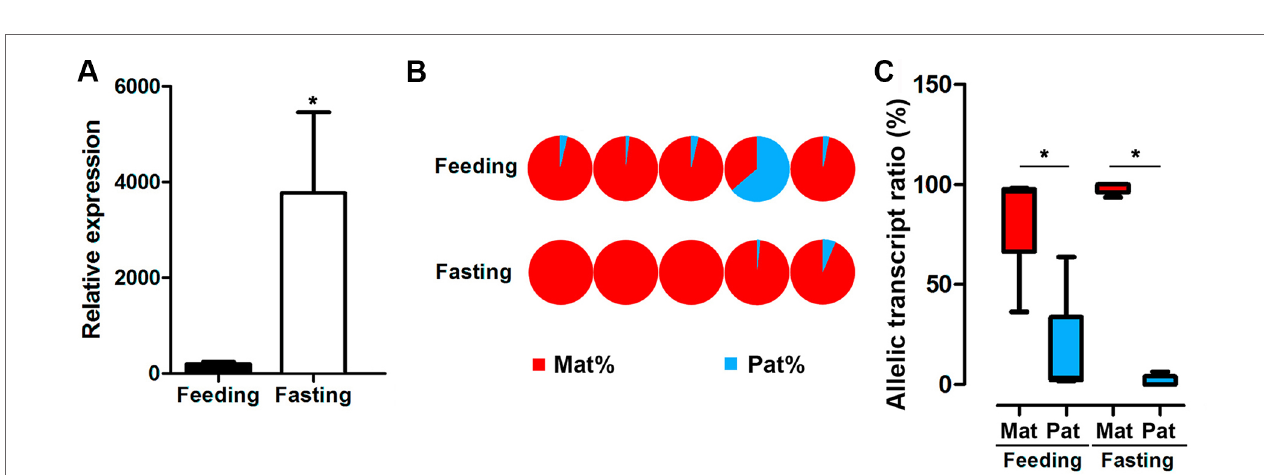
FIGURE 5 | Expression of GH in hybrid tilapia in feeding and fasting conditions. (A) Increasing overall expression of GH in hybrid tilapia by RT-PCR after fasting in hybrid tilapia. Data are presented as the mean ± SEM (n = 4). Asterisks indicate significant differences between groups ( P < 0.05). (B) ASE of GH in feeding and fasting hybrids (n = 5) by pyrosequencing based on the C/G SNP site (nucleotide 501). (C) Allelic transcript ratios of C/G in feeding and fasting hybrids. Data are presented as the mean ± SEM (n = 6). Asterisks indicate significant differences between groups ( P < 0.05). Mat, maternal; Pat,